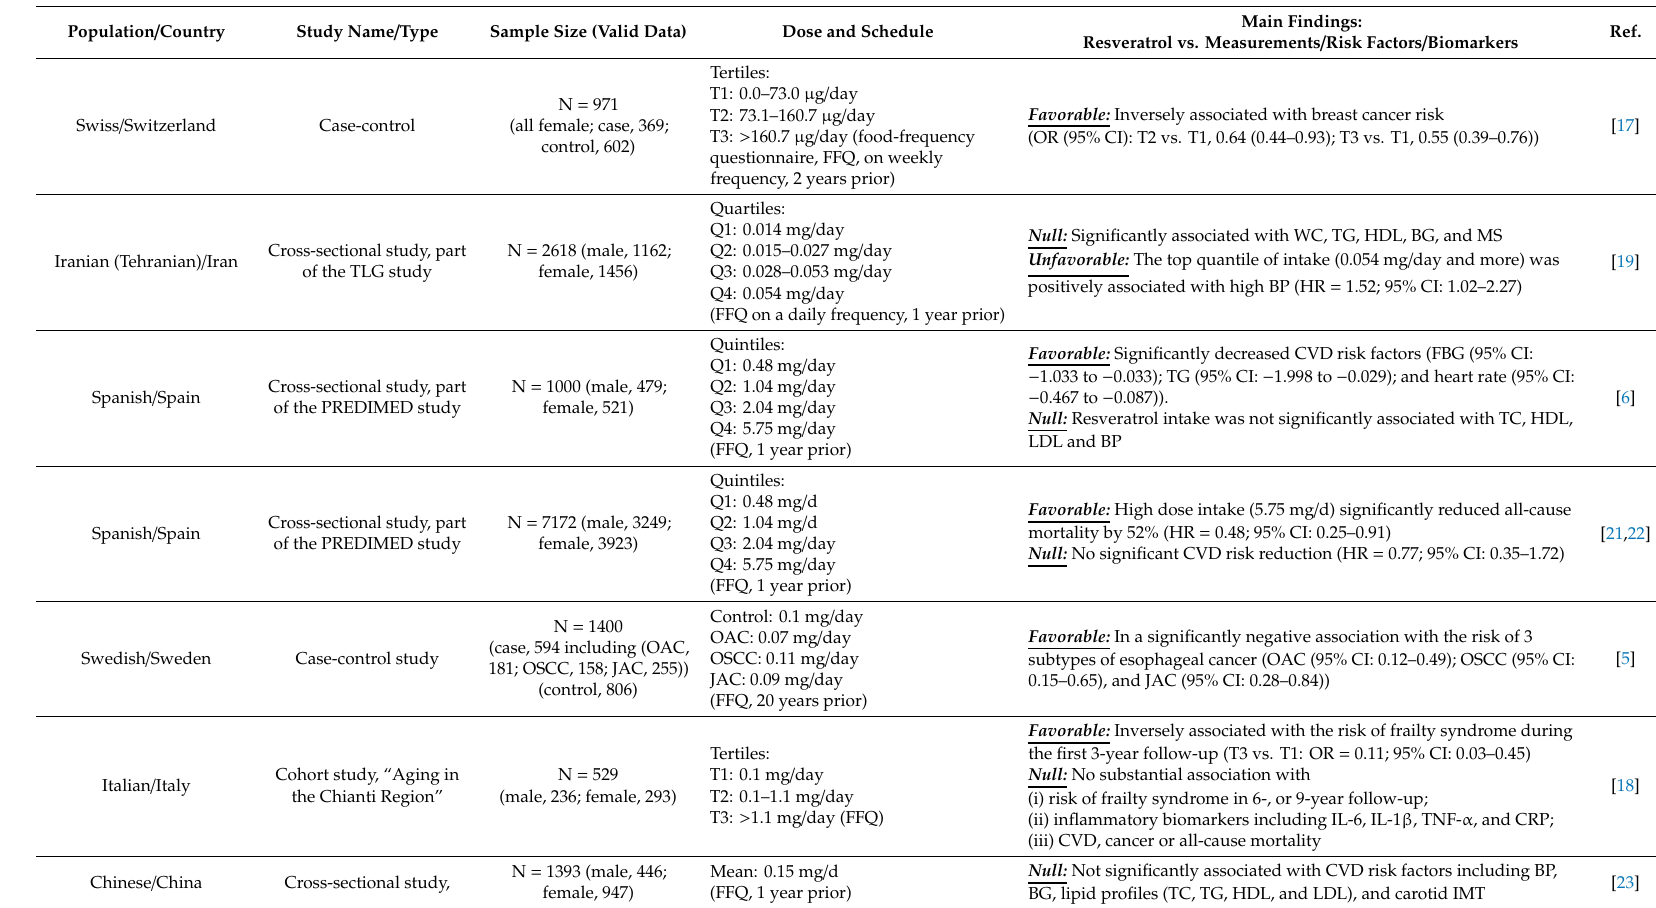
Table 1. The results of resveratrol from observational